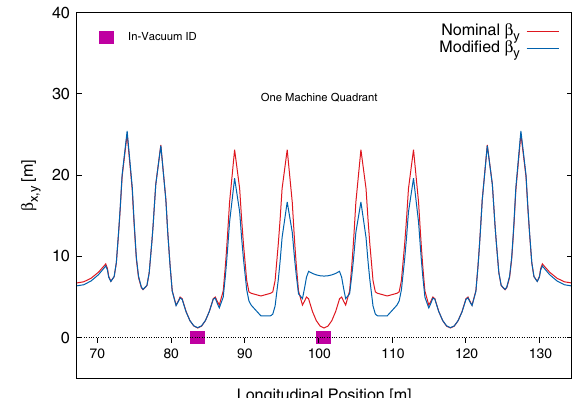
FIG. 10. Vertical betatron functions for the nominal and modified ALBA lattices. The average vertical betatron function has been increased from 1.2 m to 6.5 m at the location of one